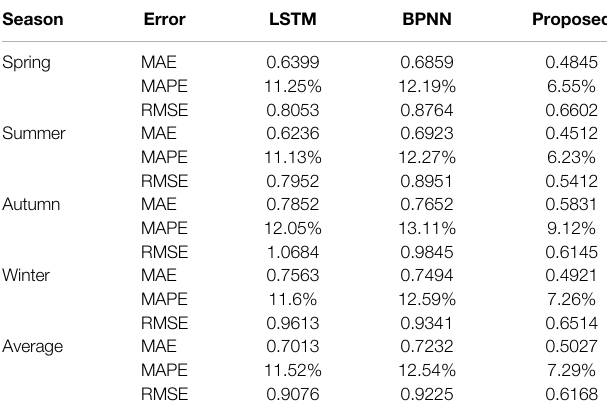
TABLE 1 | Deterministic 1 h ahead statistical prediction results of the four methods. Season